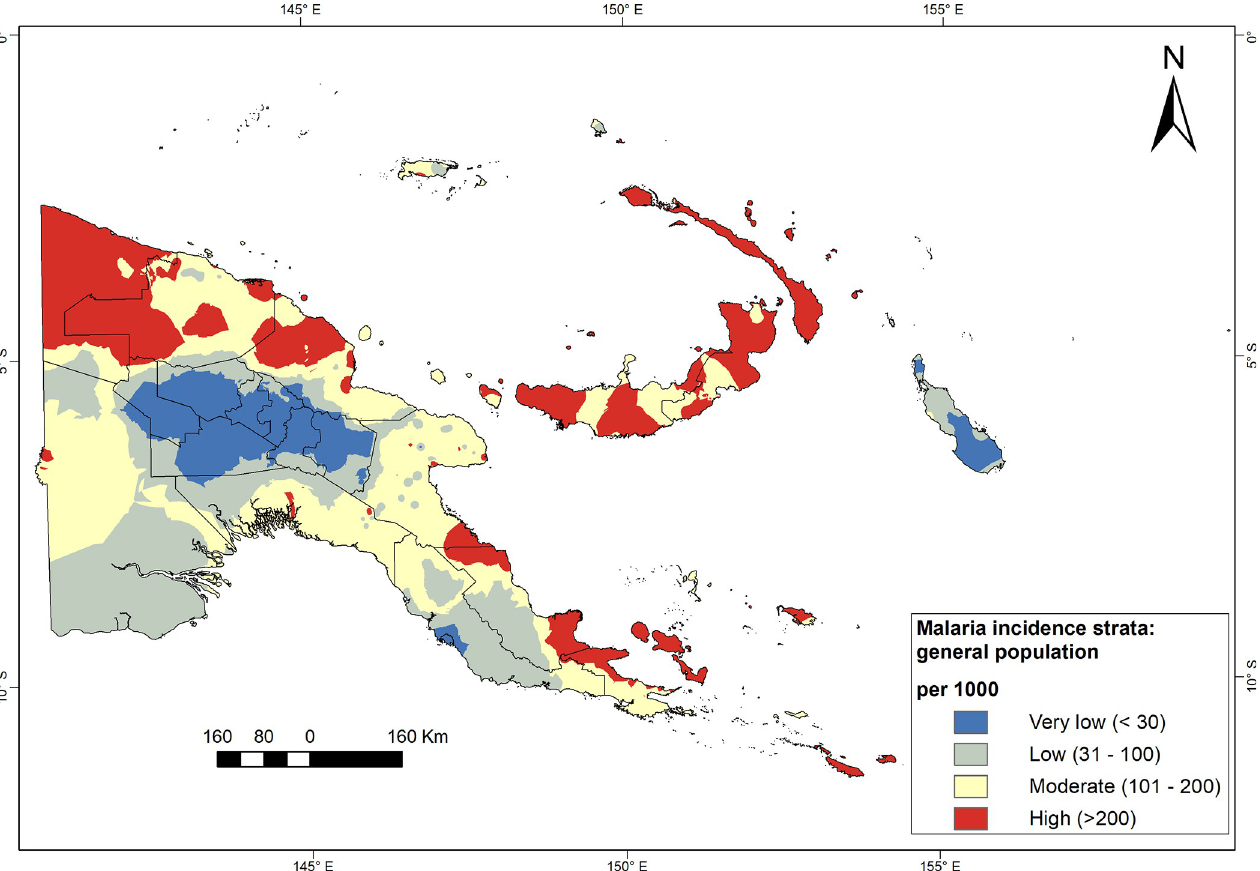
Fig 9. Malaria risk strata using the average annual incidence of cases among the general population, PNG, 2011–2019. Four strata interpolated using empirical Bayesian kriging at catchments of HFs: very low ( < 30), low (30–100), moderate (100–200), and high ( > 200 cases per 1000). Source of the map base layer: WFP-World Food Programme, 2019. Map created by the authors using a licensed ArcGIS Desktop 10.5 software from Esri (http://www.arcgis.com/).